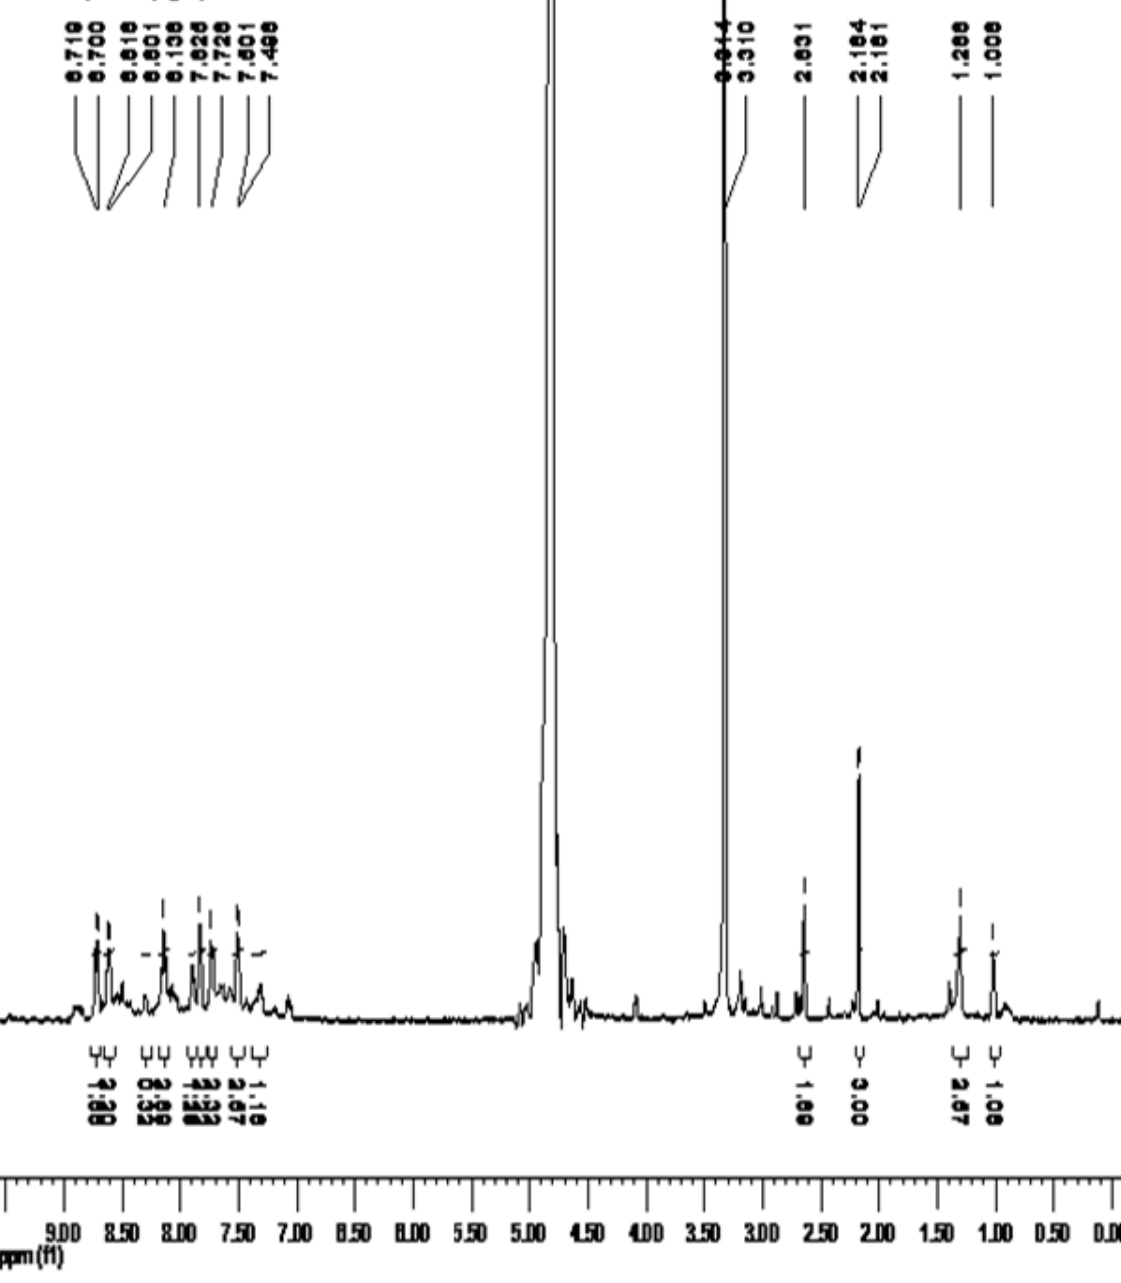
L (NCS) ] in CD 1 2 2 3